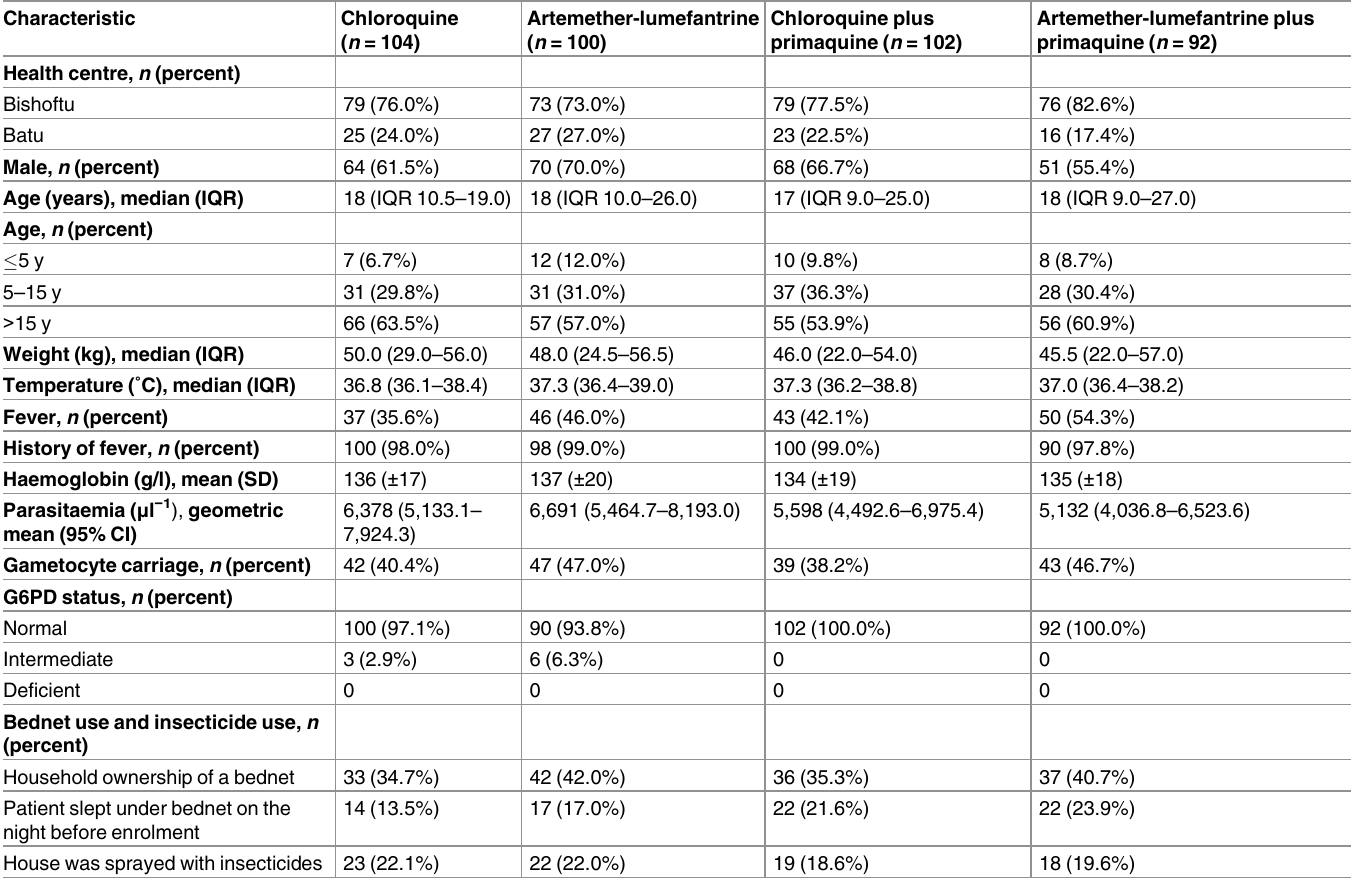
Table 1. Baseline characteristics of the study